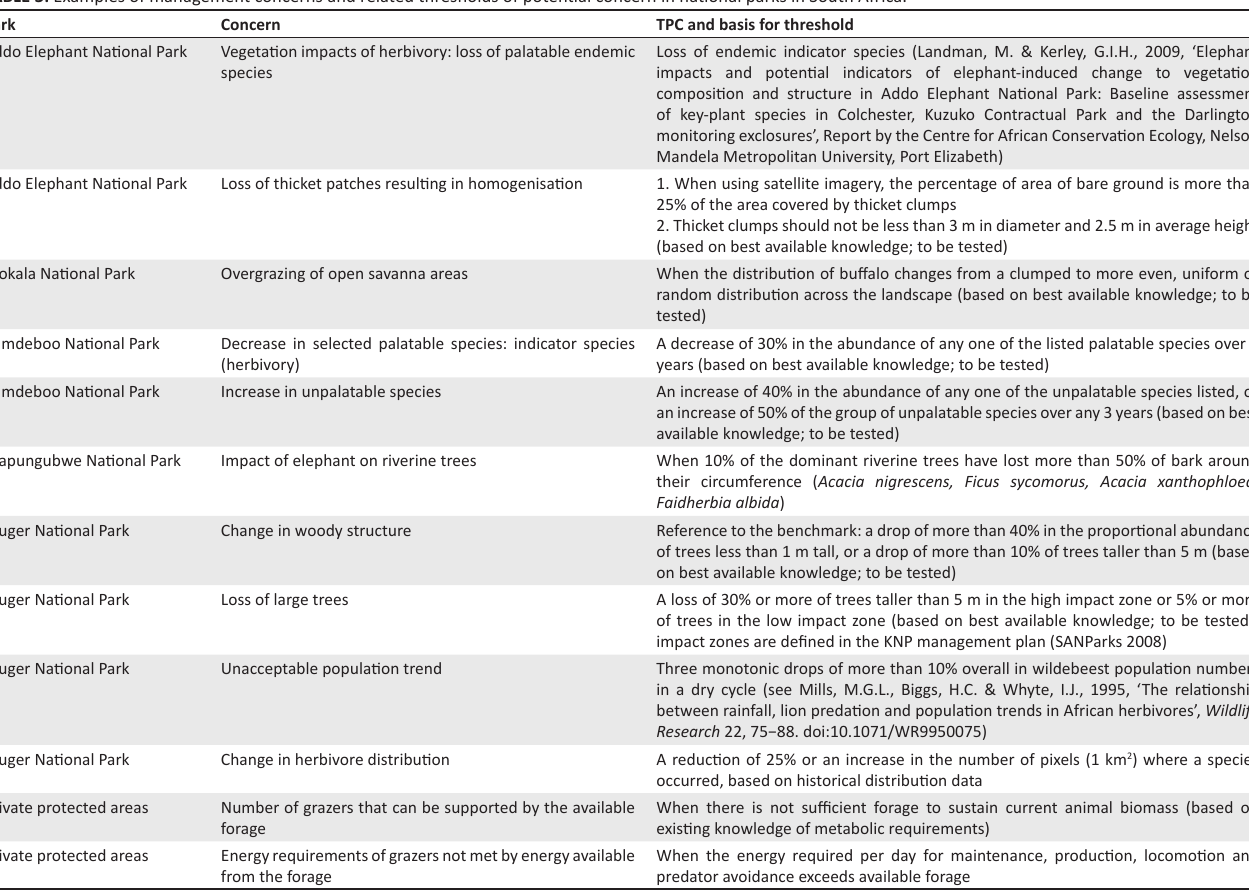
TABLE 3: Examples of management concerns and related thresholds of potential concern in national parks in South Africa. Park Concern TPC and basis for threshold Addo Elephant National Park Vegetation impacts of herbivory: loss of palatable endemic